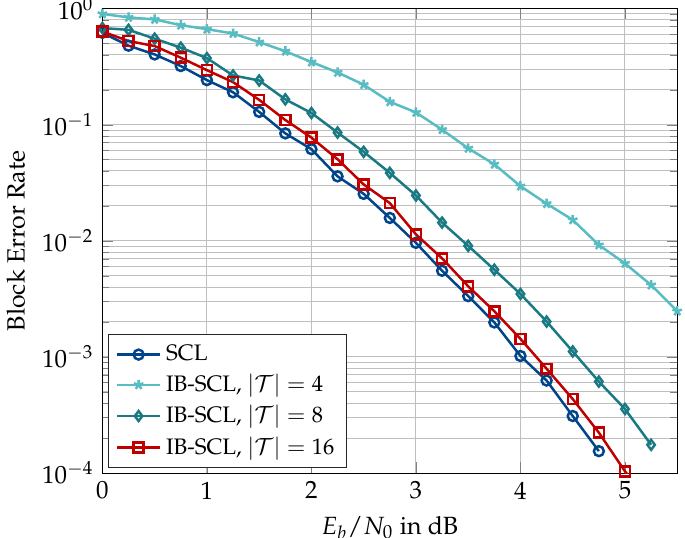
Figure 18. Block error rate comparison between conventional decoder (SCL) and information bottleneck decoders (IB-SCL) constructed for |T | = 4,8 or 16. N = 128, N L = 32, no CRC, code rate 0.5, and design E b / N 0 = 3